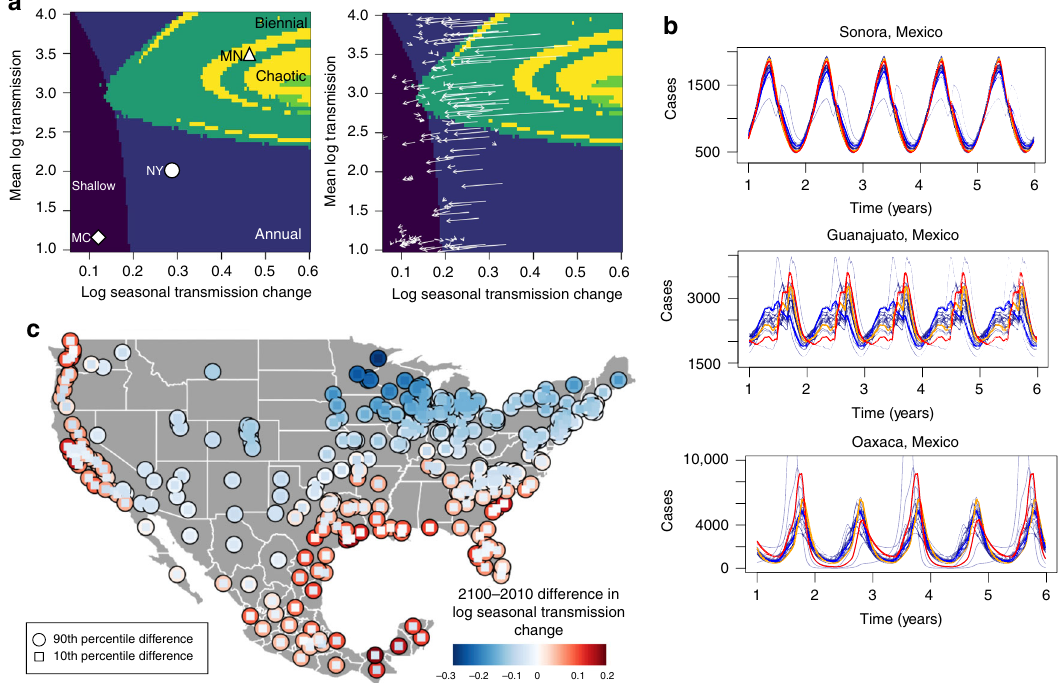
Fig. 3 Projections of RSV dynamics under different climate scenarios. a Simulated effect of log mean transmission and log seasonal transmission change (annual max – min transmission values) on dynamic pattern, holding births and initial population constant, with trajectories of current and future climate shown with arrows on the right plot. b Simulated epidemic dynamics for three states in Mexico using precipitation projections from all climate models (gray lines). Ninetieth percentile (red), 50th percentile (orange), and 10th percentile (blue) in terms of the amplitude of seasonal transmission are highlighted. c Map of the uncertainty in the projected 2100 – 2010 difference to log seasonal transmission change where outer circles is the upper 90th percentile and inset blue squares are the 10th percentile